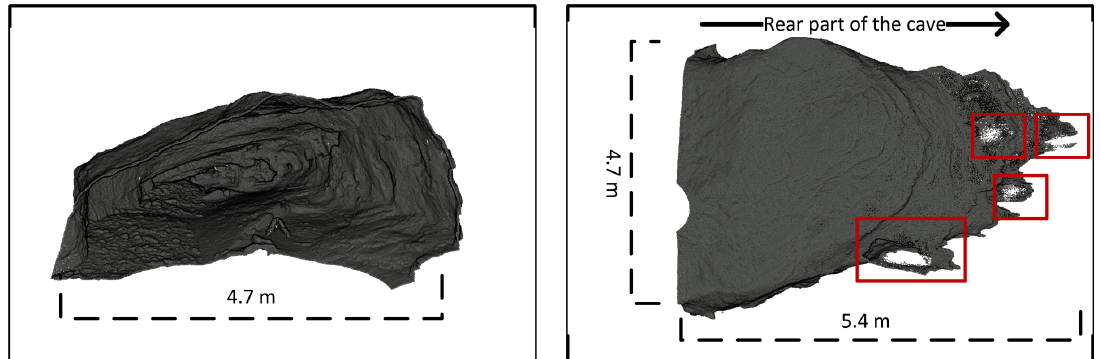
Figure 1. Shaded representation of the cave point cloud: a look inside (left) and from the outside (right). The red rectangles represent occluded regions.